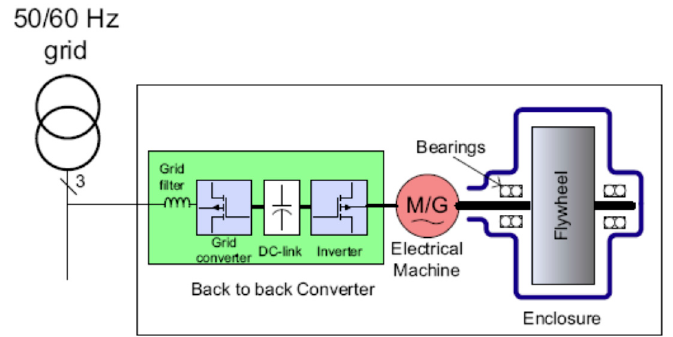
Figure 5. Components of the Flywheel Energy Storage System (FESS). Reprint with permission [53]; Copyright 2017, Elsevier.